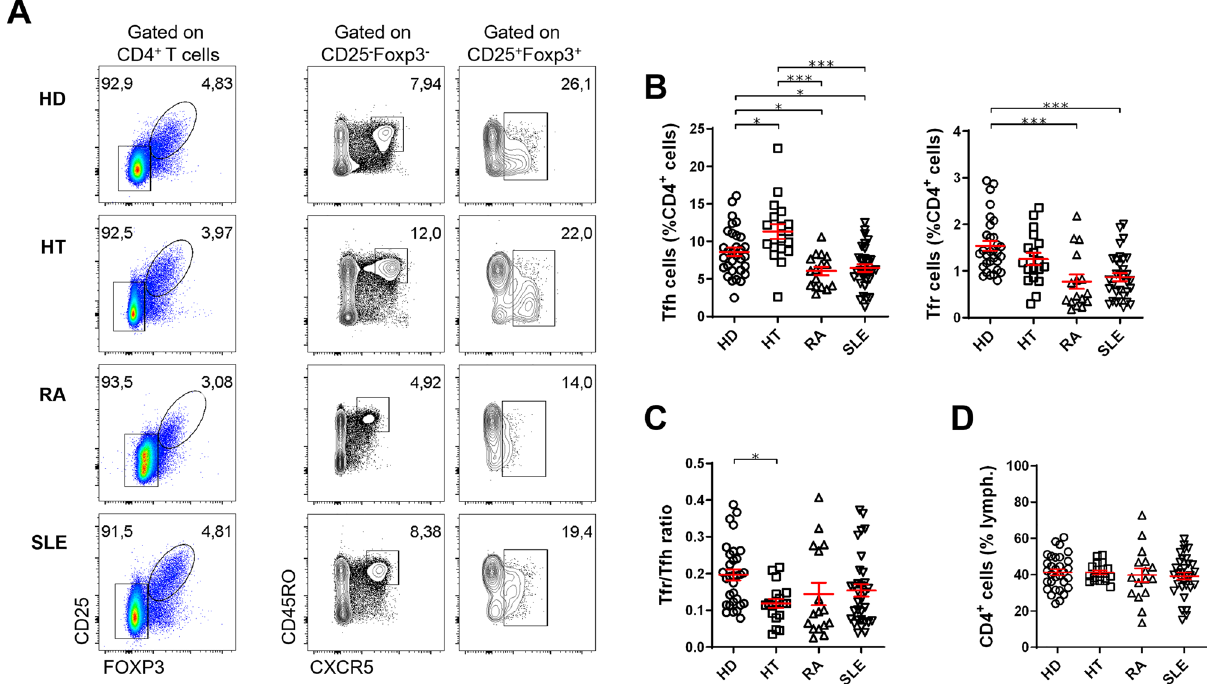
Figure 1. The circulating Tfr/Tfh ratio is heterogeneous among different autoimmune diseases. (A) Representative plots and (B) pooled data of the frequency of CD4 + CXCR5 + CD25 – Foxp3 – Tfh cells and CD4 + CXCR5 + CD25 + Foxp3 + Tfr cells in peripheral blood of patients with Hashimoto’s thyroiditis (HT, n = 18), rheumatoid arthritis (RA, n = 16), systemic lupus erythematosus (SLE, n = 32), and sex- and age-matched healthy donors (HD, n = 31). (C) Blood Tfr/Tfh ratio and ( D ) frequency of CD4 + T cells in HT, RA, SLE, and sex- and age-matched HD. Each data point represents one individual subject; bars represent mean ± SEM; * p < 0.05, ** p < 0.01, *** p < 0.001, Kruskal–Wallis one-way analysis of variance (ANOVA) test with Dunn’s comparison